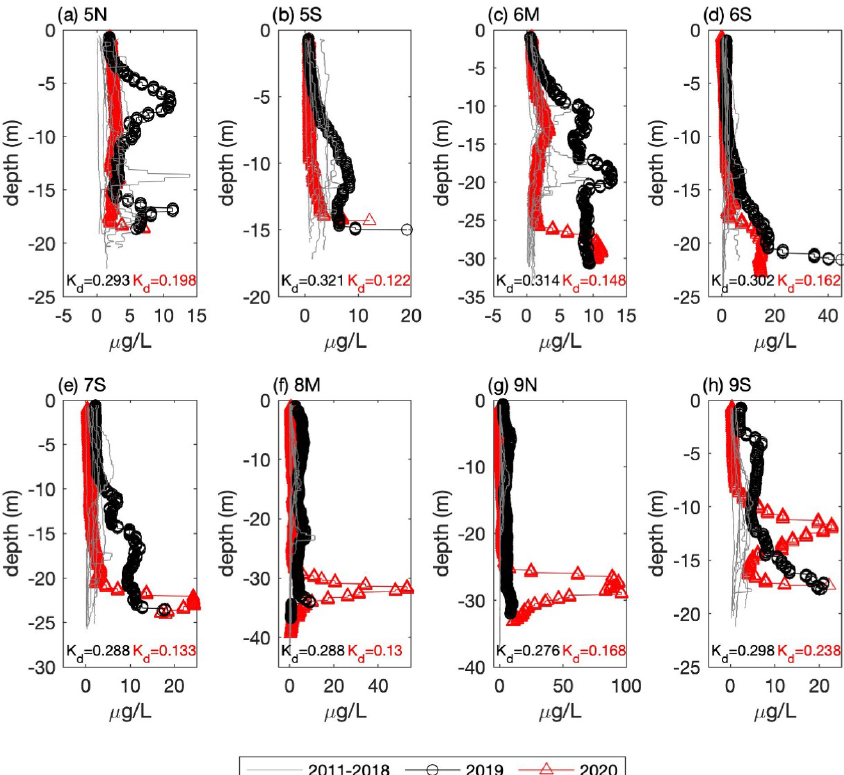
Figure 5. Vertical profiles of chlorophyll fluorescence from the September CCS cruises for all eight CCB stations (see Fig. 1 for locations). Data from 2011–2018 are plotted as grey lines and 2019 and 2020 as circles and triangles, respectively. Estimates of the light attenuation coefficient ( K d ) for the 2019 (black) and 2020 (red) profiles are reported at the bottom of each